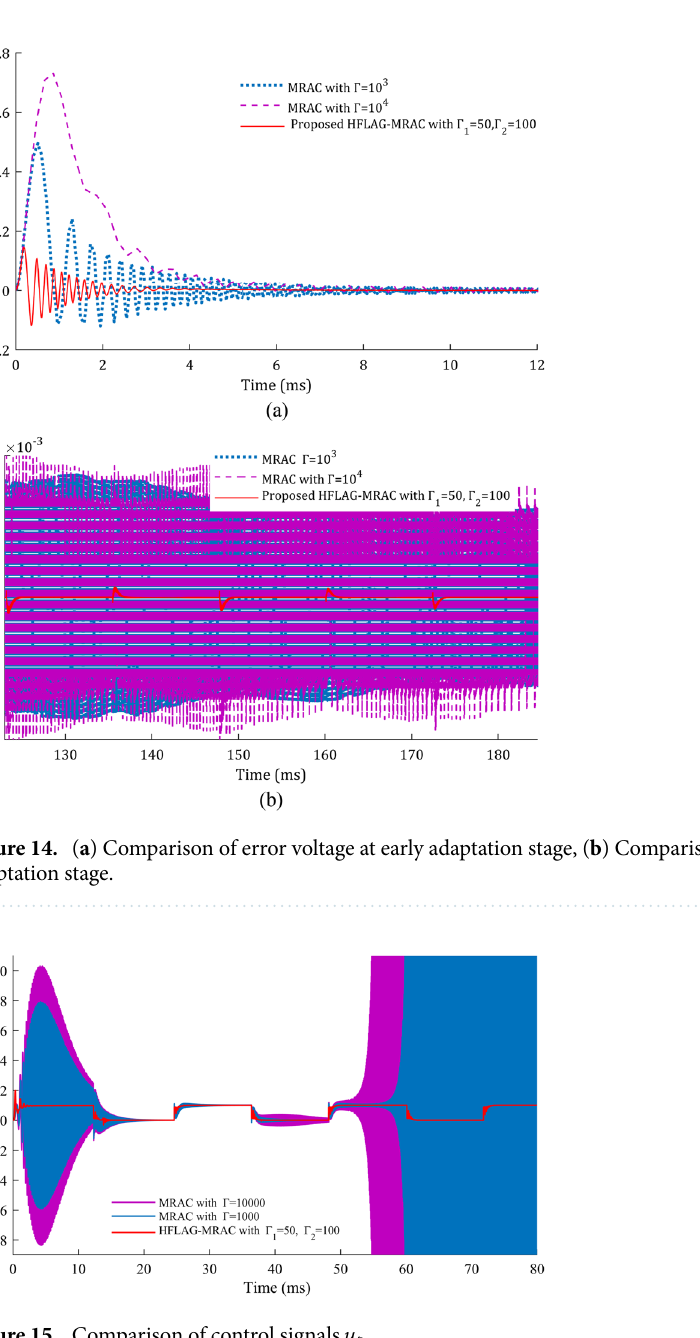
Figure 15. Comparison of control signals u p